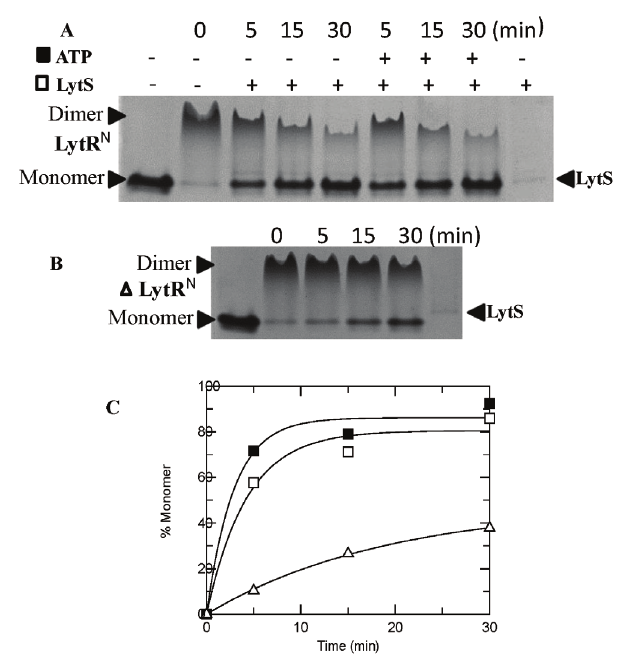
Figure 6. The phosphatase activity of LytS and autophosphatase activity of LytR N . ( A ) LytS at 5 µM was incubated with LytR N -P at 80 µM at different time intervals, in the absence or presence of 200 µM ATP, at 37°C. ( B ) The stability of phosphorylated LytR N -P at 37°C. ( C ) Time-dependence of the phosphatase activity of LytS in the absence of ATP (empty squares) or presence of ATP (solid squares) and autophosphatase activity of LytR (empty triangles). The data points were taken from the analyses of panels A and B using NIH ImageJ (Dataset